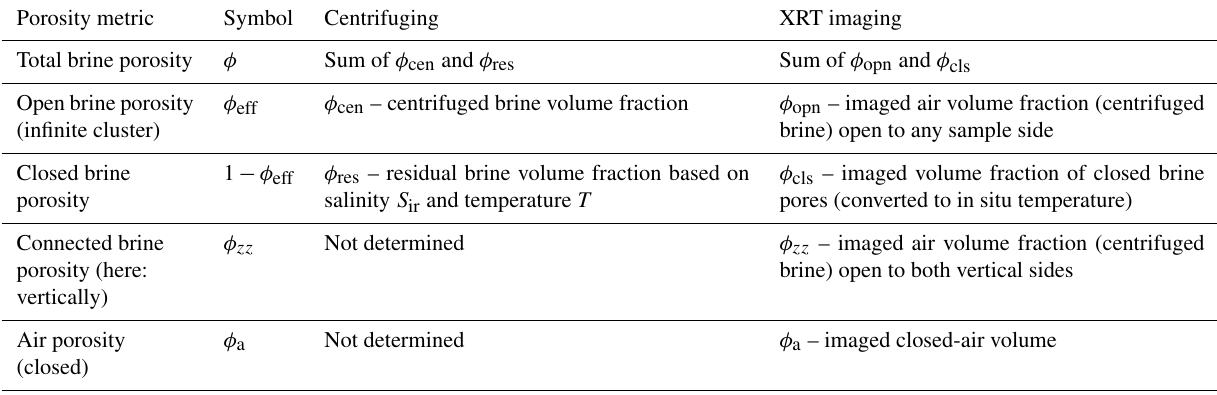
Table 1. Porosity metrics and their determination.